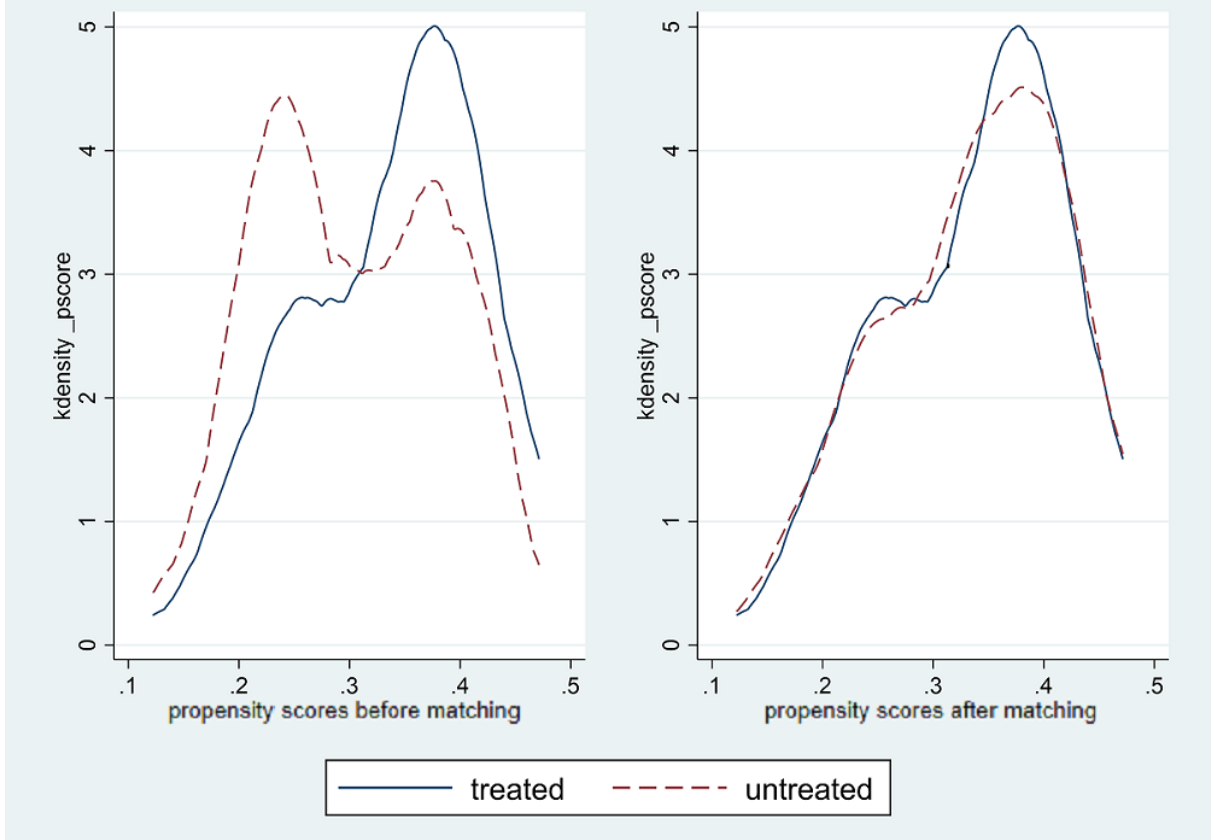
Matched sampleUnmatched sampleVariables